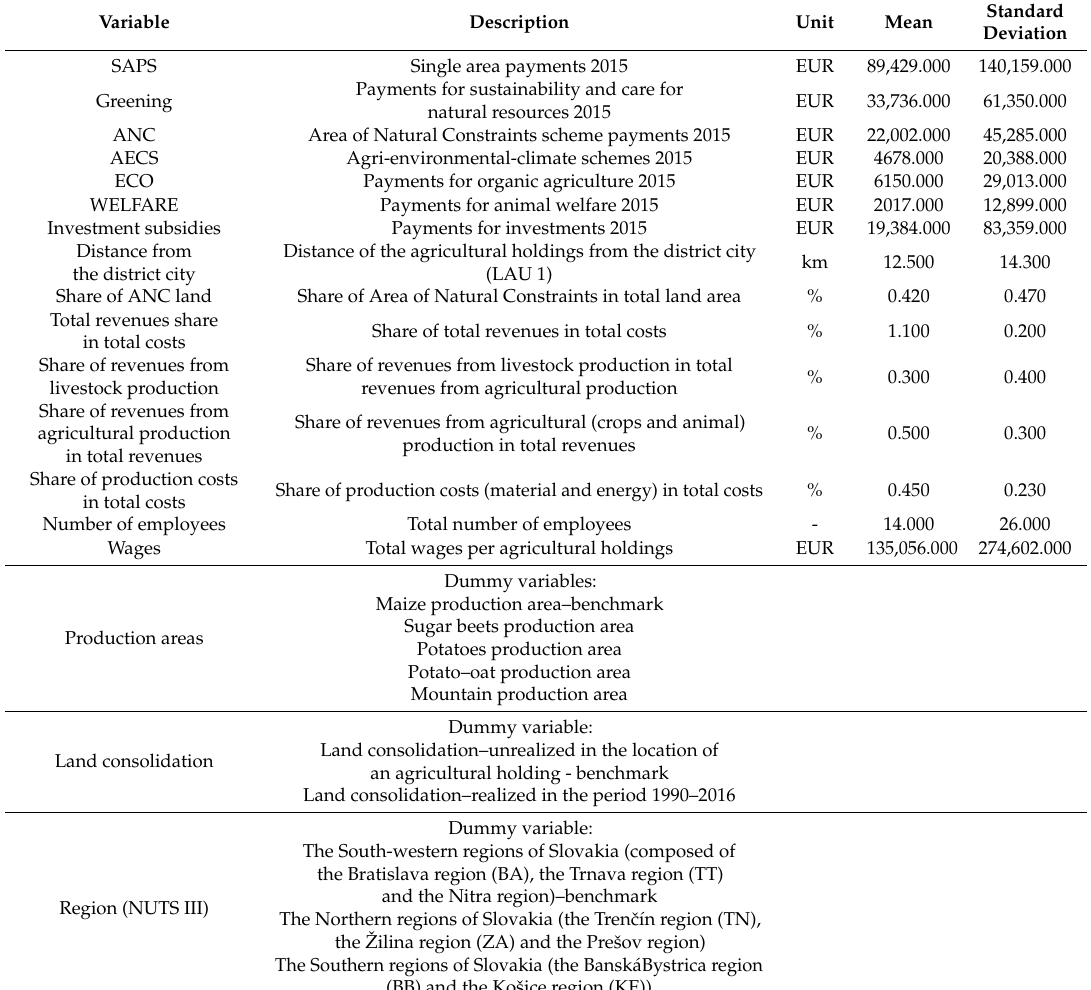
Table 1. Descriptive statistics of the independent variables of agricultural holdings in